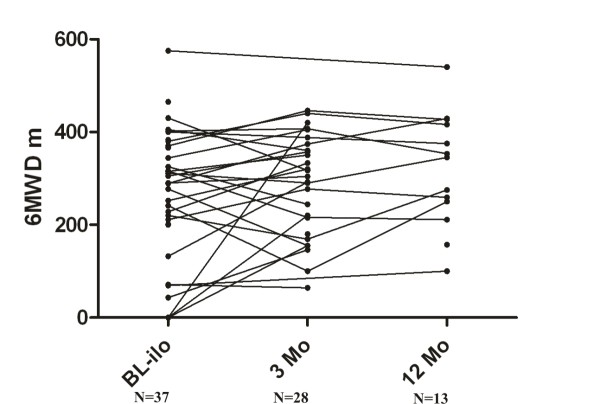
Available data of 6MWD for each patient at different time points e.g. start of iloprost (BL-ilo), 3 months (3 Mo) and 12 months (12 Mo) after iloprost initiation. The median of the 6MWD increased from BL-ilo to 3 Mo and 12 Mo (289 m vs. 298 m vs. 345 m). However, the between group differences were not statistical significant (one-way ANOVA: p = 0.09)